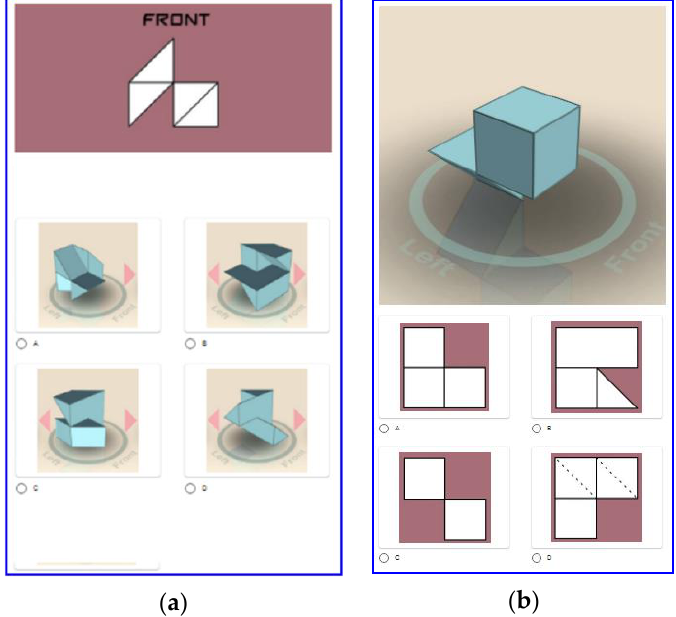
Figure 2. The appearance of the task used in experiment II: ( a ) an example of a 2D test used in the experiment; ( b ) an example of a 3D test used in the experiment.